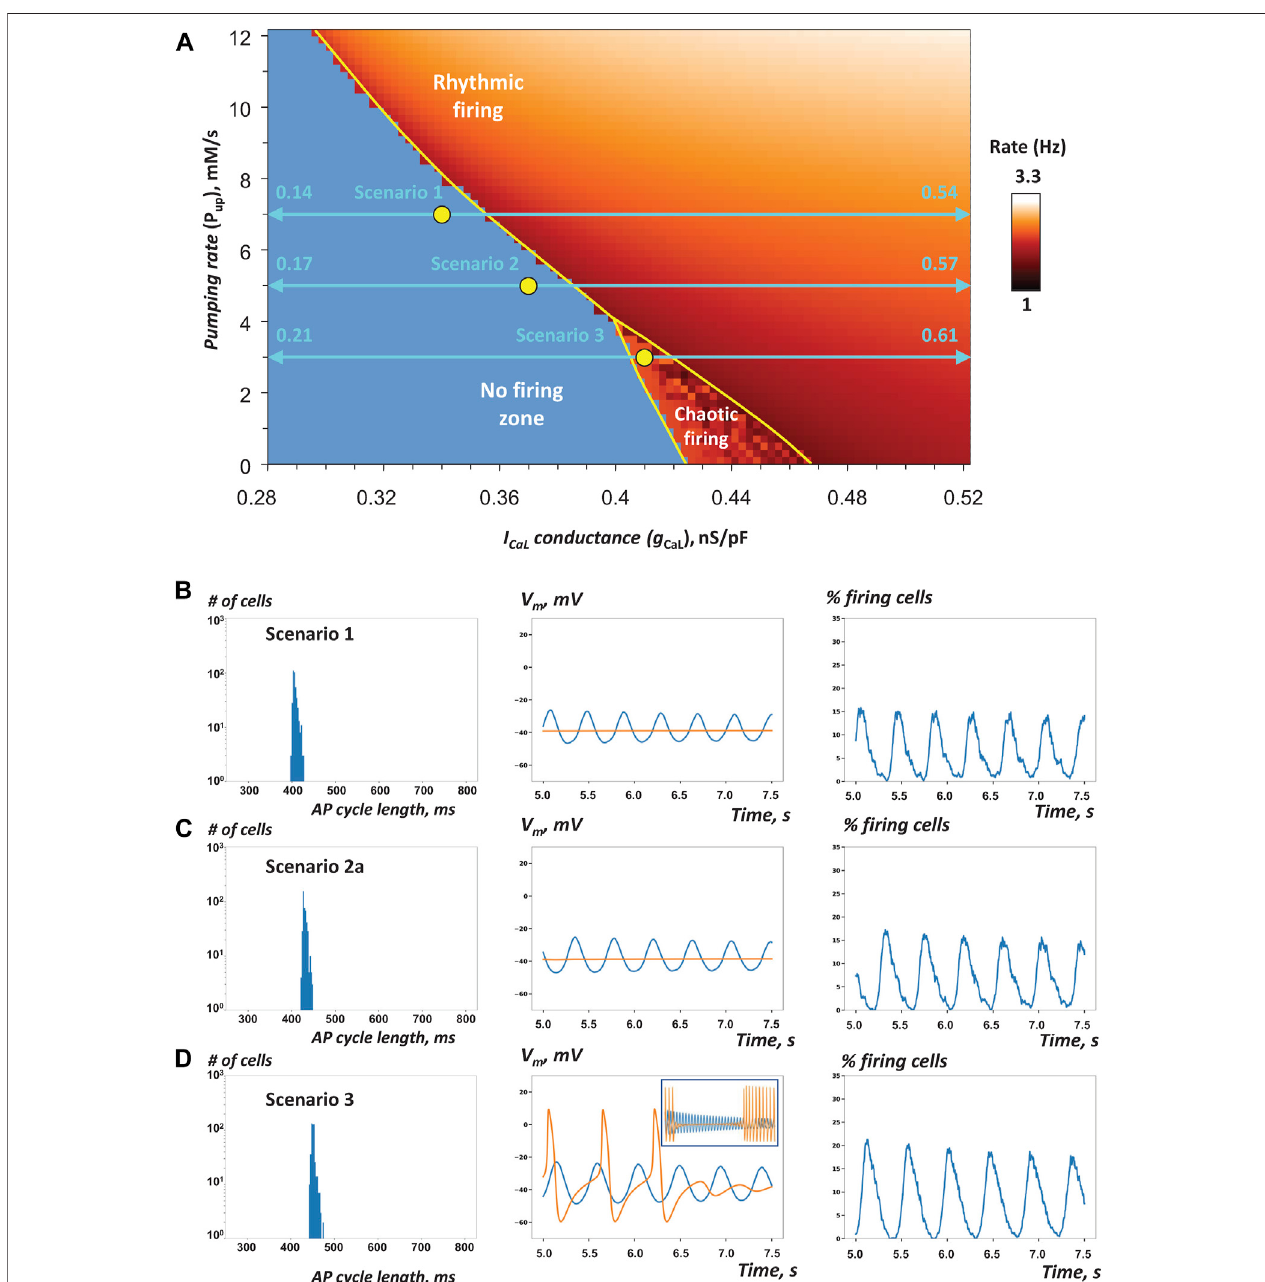
FIGURE 3 | Heterogeneity in g CaL increases robustness of AP fi ring in SAN tissue models close to the edge of stability (A) P up - g CaL bifurcation diagram previously reported for single SAN cell model (modi fi ed from (Maltsev and Lakatta, 2009)) shows the parametric space for rhythmic AP fi ring, no fi ring, and chaotic fi ring (white labels). Yellow circles show coordinates for fi xed P up and g CaL mean values (all in the non- fi ring zone) in cell populations used in our simulations of SAN tissue function in three speci fi c scenarios 1, 2, and 3 ( Table 1 ) close to the bifurcation line (yellow line). Double-headed aqua arrows show the g CaL ranges for each scenario (Note: the ranges extend beyond the diagram, with the labels showing the extensions). All three tissue models fi red rhythmic APs ( Supplementary Movies S1 – 3 ). B – D : Each panelshowstheresultsofsimulationsineachscenario:histogramsofAPcyclelengthdistribution,space-average V m vstime,andthepercentageof fi ringcells( V m > 0)vs time (from 5 to 7.5 s). In scenario 3, we extended the simulation run to 25 s. Inset in panel D (middle) shows average V m from 5 to 25 s. Orange traces show space- average V m vs time for the control SAN tissue model populated by identical cells with average P up and g CaL values of the respective heterogeneous model.